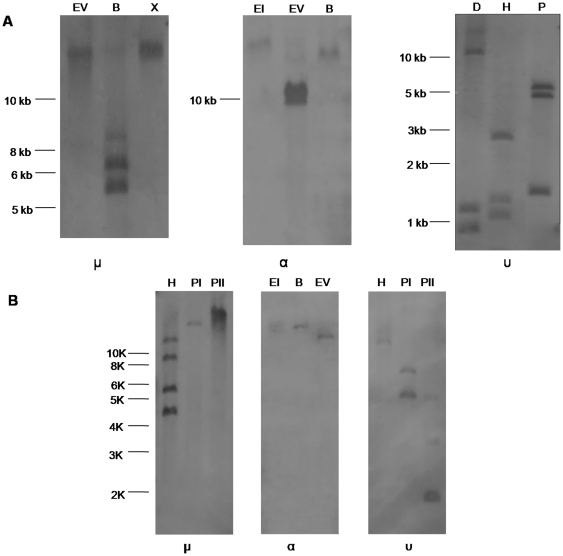
Southern blot detection of the ostrich Ig heavy chain constant-region genes.A. Southern blot detection of the ostrich Ig heavy chain constant region genes using Cμ-, Cα-, and Cυ-specific full-length probes. EI, EcoR I; EV, EcoR V; B, BamH I; X, Xba I; D, Dra I; H, Hind III; P, Pst I. B. Southern blot detection of the ostrich Ig heavy chain constant region genes using Cμ4, Cα3, Cυ4 single-exon probes. EI, EcoR I; EV, EcoR V; B, BamH I; H, Hind III; PI, Pst I; PII, Pvu II.